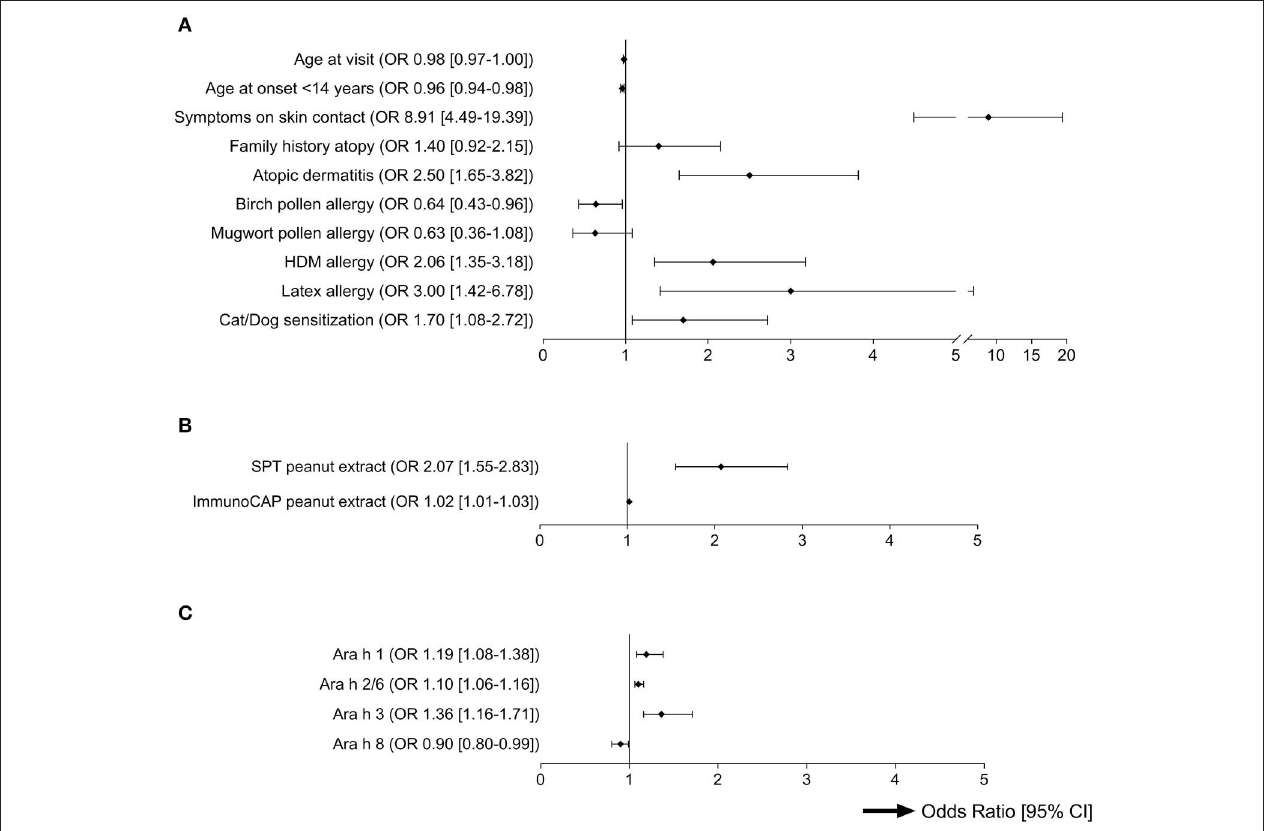
FIGURE 1 | Univariable Odds Ratios for prediction of severity of probable PA ( p < 0.2). This forest plot shows the ORs and their respective confidence intervals from univariable analyses of all predictors for severity of probable peanut allergy with p < 0.2 ( Table 1 ). All variables under (B) and (C) , and in (A) “age at visit” were entered as continuous variables. All other variables were dichotomous. (A) Demographics and clinical background. (B) Sensitization to peanut extract. (C) Sensitization to peanut